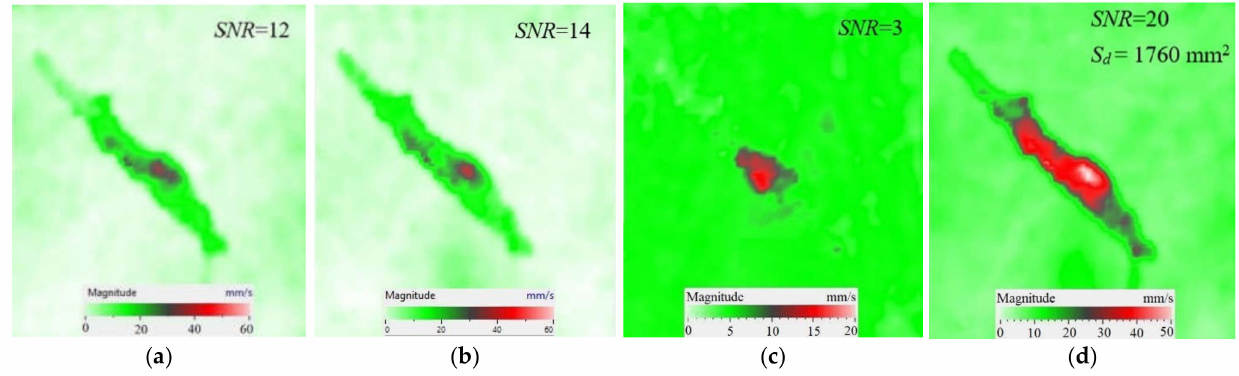
Figure 10. Frequency band data of CFRP sample by x ( a ), y ( b ), z ( c ) and x, y, z ( d )